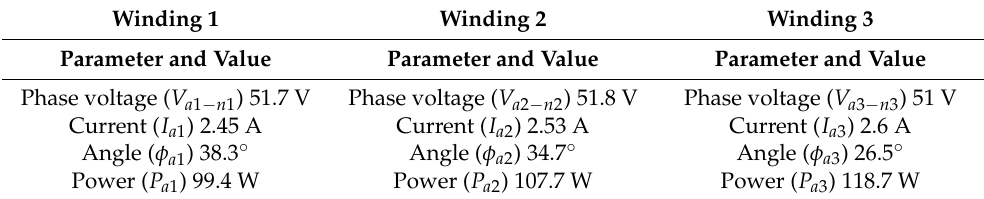
Table 8. Obtained values of the locked rotor test carried out by independent sets at the asymmetrical nine-phase IM.